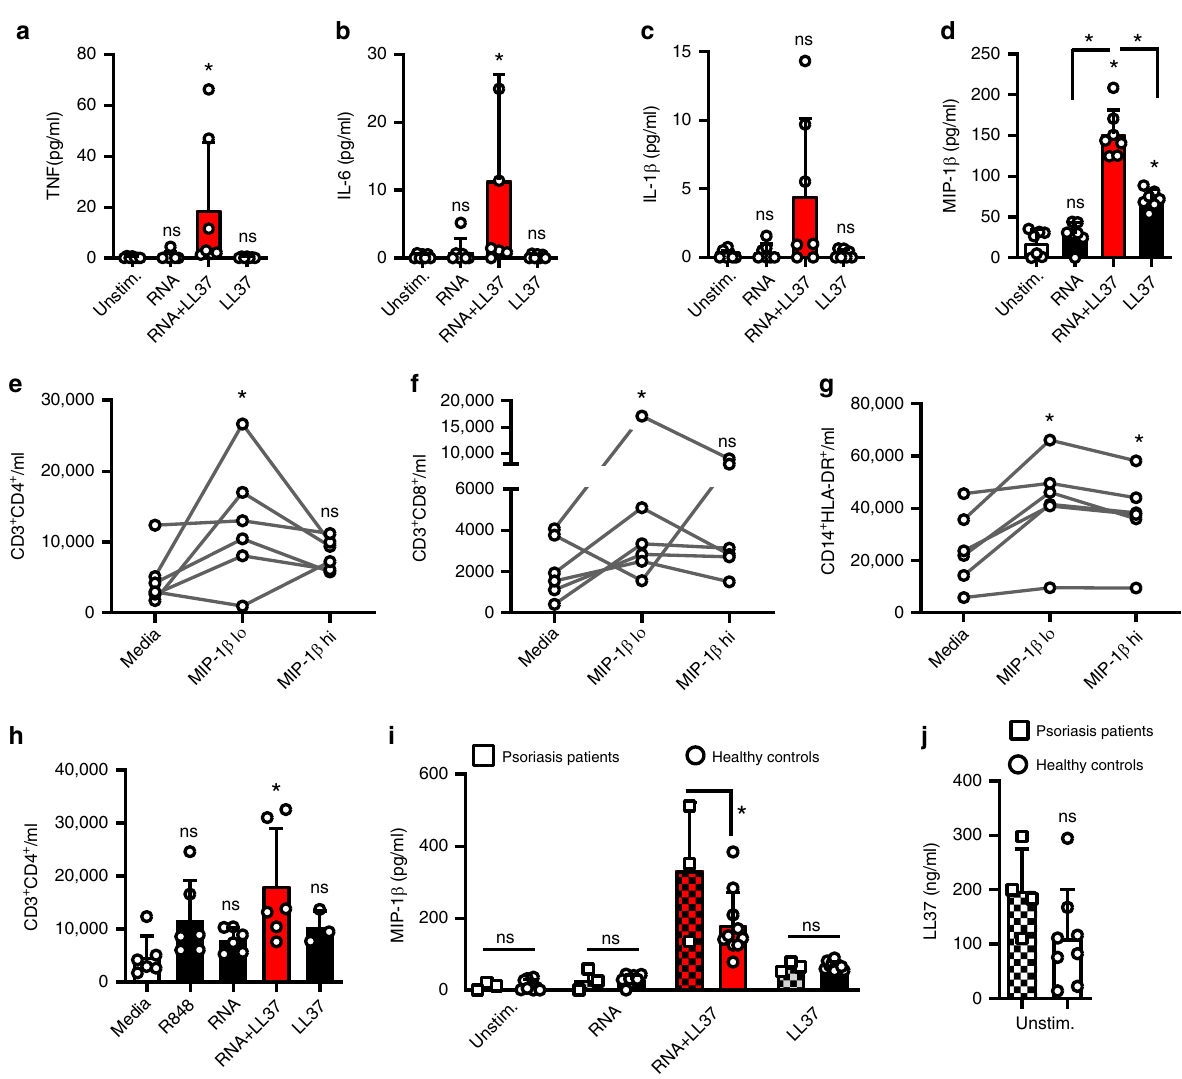
Fig. 2 RNA-LL37 promote the release of cytokines and chemokines. Cytometric bead array ( a – c ) or ELISA ( d ) for TNF ( a ), IL-6 ( b ), IL-1 β ( c ), or MIP-1 β ( d ) secreted from PMNs stimulated for 4 h as indicated ( n = 6). Flow cytometric cell counts of migrated CD4 + T cells ( e , h ), CD8 + T cells ( f ) and CD14 + HLA-DR + monocytes ( g ) quanti fi ed in transwell assays with total PBMCs in the upper and MIP-1 β (30 and 150 pg/ml) ( e – g , n = 6 – 7) or R848, RNA with and without LL37 ( h , n = 3 – 7) in the lower chamber. i ELISA of MIP-1 β secreted from psoriasis PMNs ( n = 3 patients, 10 healthy controls, squares, chequered bars) or PMNs from sex and age-matched healthy donors. Only responses to treatment compared. j as in I but ELISA for LL37 ( n = 4 patients, 7 healthy donors). Panels ( a – j ) represent combined data (mean + SD) from ‘ n ’ biological replicates (each dot represents one donor). * p < 0.05 according to Friedmann ( a , b , e , f ) or Kruskal – Wallis ( c , h ) test with Dunn ’ s correction, or one-way ANOVA with Dunnett ’ s ( d , g , h ) or Sidak ( i ) correction or Student ’ s t -test ( j ). Source data is provided as a Source data fi